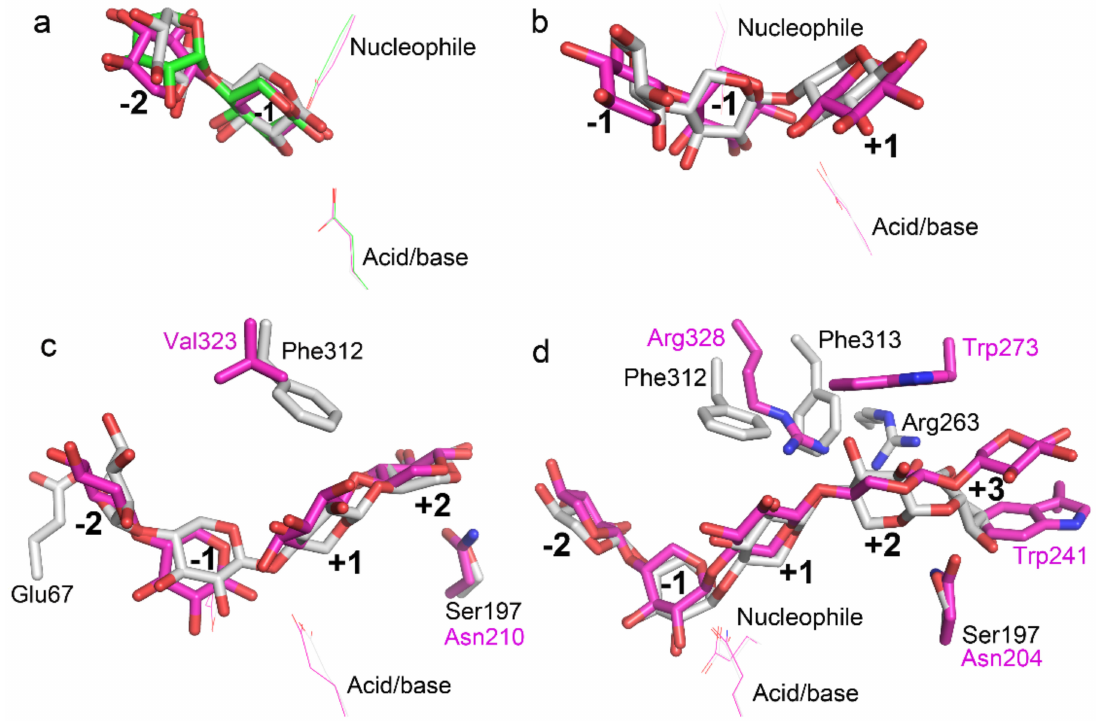
Figure 7. Superposition of TmxB xylooligosaccharide (XOS) (docking) and determined complex structures. ( a ) Superposition of the docking structure of TmxB-X2 (gray), crystal structure of TmxB-X2 (green, PDB entry:1VBR), and xylanase 10B from T. petrophila RKU-1 in complex with X2 (magenta, PDB entry: 3NJ3). ( b ) Superposition of docking structure of TmxB-X3 (gray) and crystal